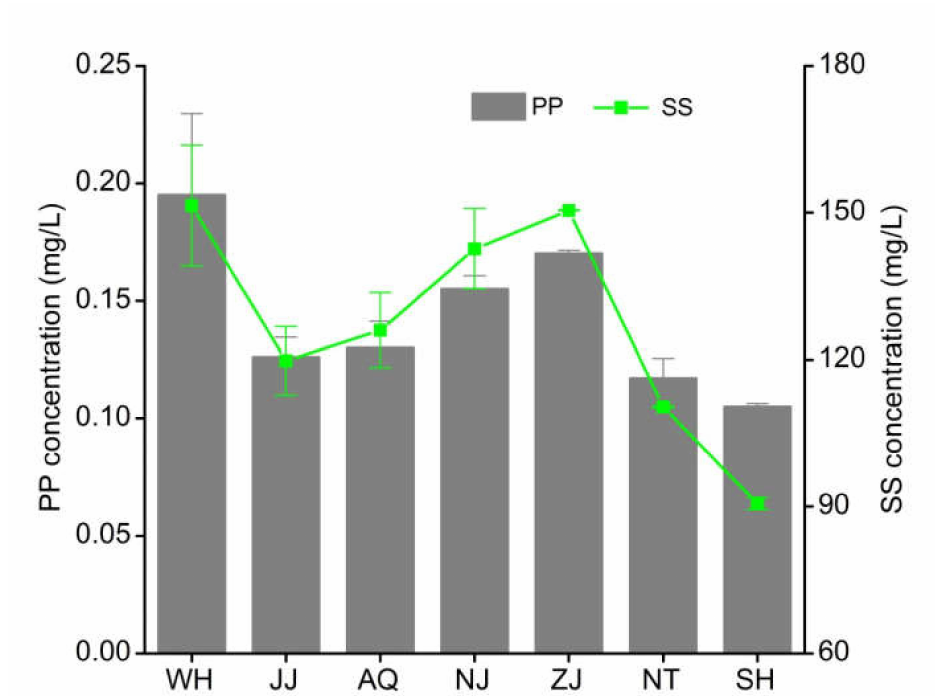
Figure 3. Distribution of PP and suspended sediment (SS) of water samples in the main urban river stretches along the middle and lower reaches of Yangtze